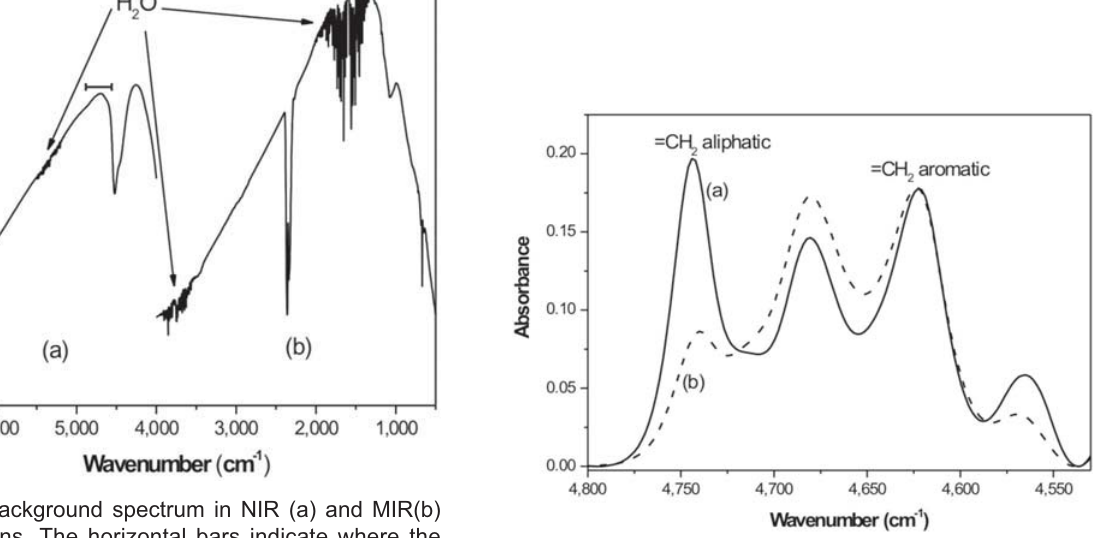
FIGURE 4- TPH absorption bands in the NIR region before (a) and after (b)